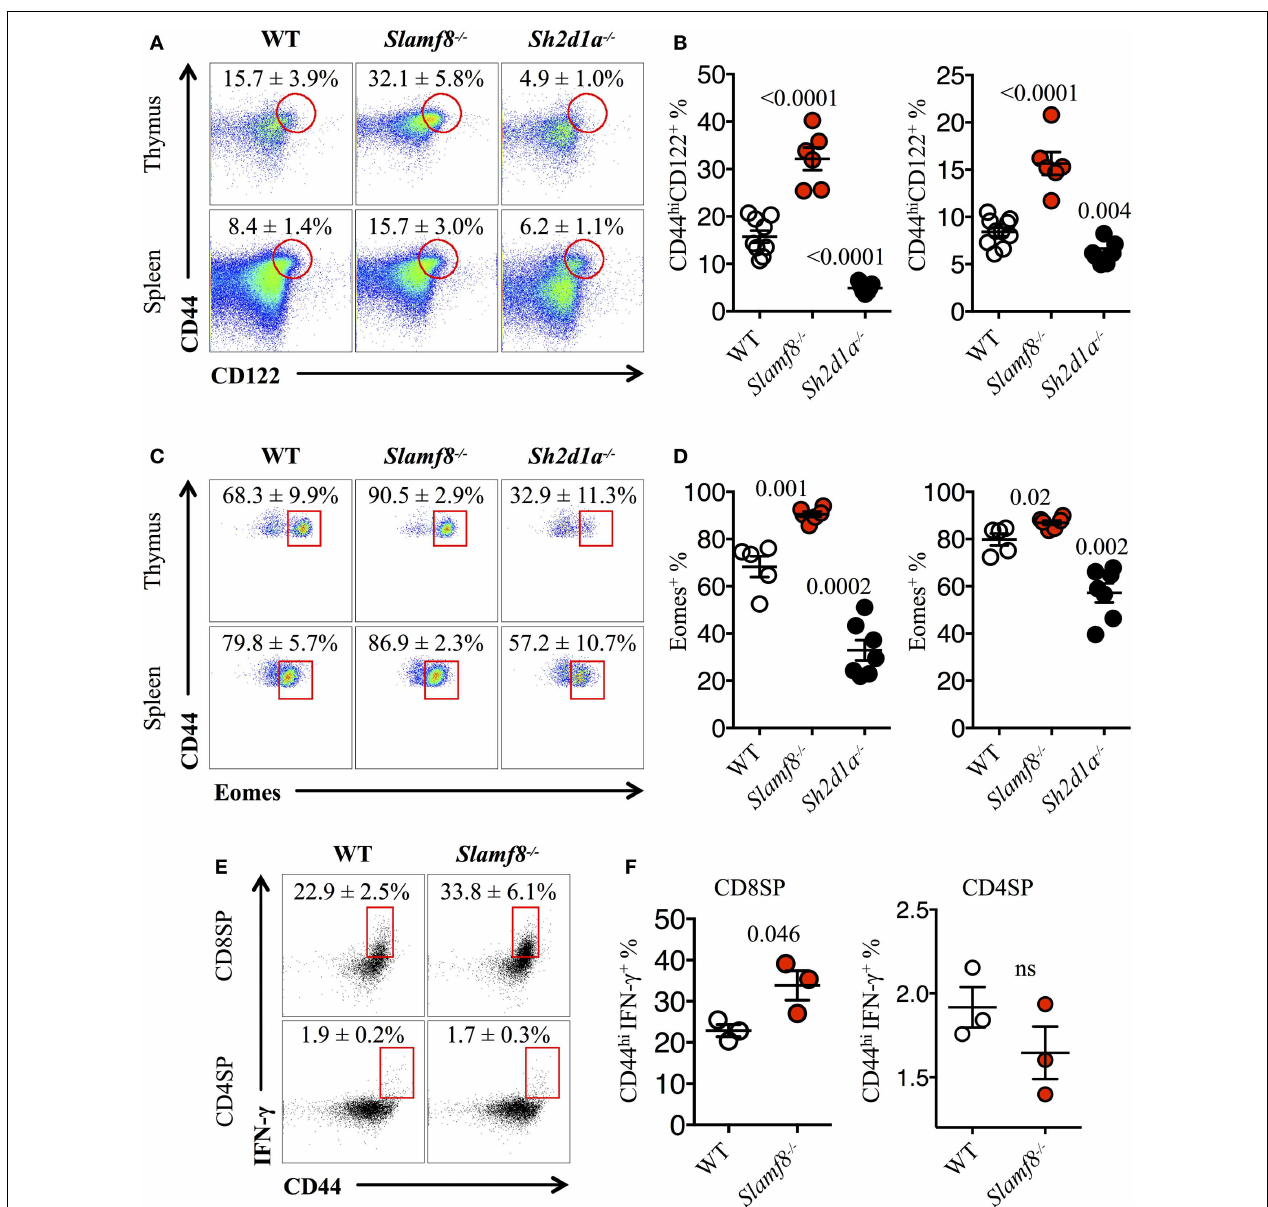
Eomes + innate-like CD8 + T cells in thymus ( left ) or spleen ( right ) ofWT, Slamf8 − / − or Sh2d1a − / − BALB/c mice. (E) Intracellular staining for IFN- γ after ex vivo activation with PMA and ionomycin ofWT or Slamf8 − / − BALB/c thymocytes. (F) Percentage of CD44 hi IFN- γ + CD8SP ( left ) or CD44 hi CD4SP ( right ) ofWT or Slamf8 − / − BALB/c thymocytes. Numbers inside plots show the mean percentage ± SD of the indicated population. Cumulative graphs show the results of four independent experiments, mean ± SEM.The p values were calculated by unpaired t -test between theWT group and the Slamf8 − / − or Sh2d1a − / − group. A value of p < 0.05 was considered significant; ns,